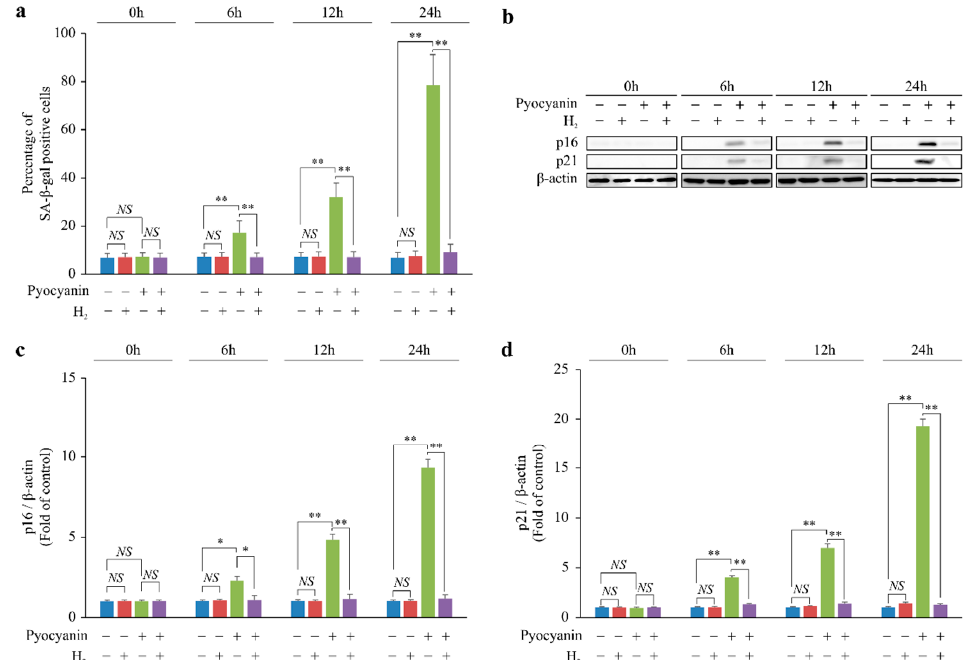
Figure 1. H 2 suppressed cytoplasmic hydroxyl radical (cyto • OH)-induced cellular senescence via p16 and p21 in vitro. ( a – d ) The effect of H 2 at 0, 6, 12, and 24 h in the cyto • OH-induced oxidative stress model using pyocyanin-stimulated mouse embryonic fibroblasts (MEFs). ( a ) Cellular senescence and ( b , c ) p16 and ( b , d ) p21 expression in pyocyanin-stimulated MEFs determined by β -galactosidase (SA- β -gal) staining and Western blot analysis, respectively. The data are presented as the mean ± SEM ( n = 5 per group); * p < 0.05; ** p < 0.01; NS, not